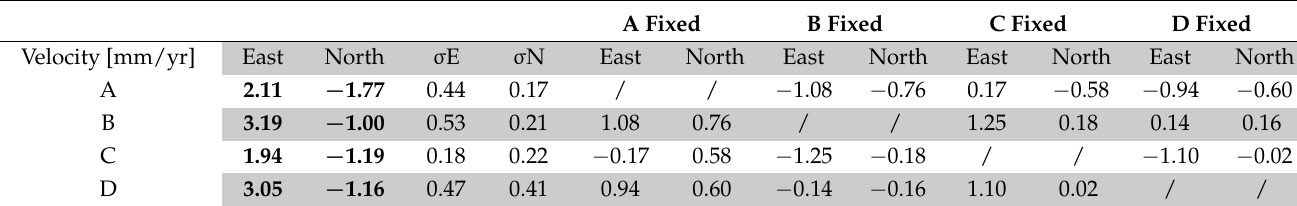
Table 1. Relative horizontal velocity of each crustal block (as defined in Figure 8B) with respect to the others. A Fixed B